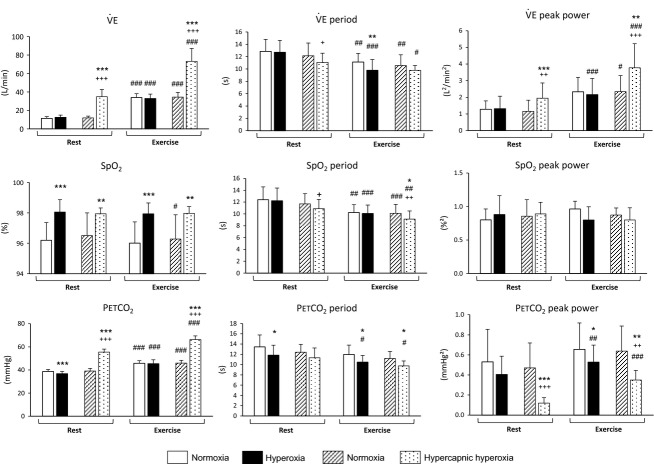
Mean (±SD) values of , SpO2, and PETCO2 and corresponding periods and peak powers in normoxia, hyperoxia, and hypercapnic hyperoxia. Exercise versus Rest: #P < 0.05; ##P < 0.01; ###P < 0.001. Hypercapnic hyperoxia or hyperoxia versus normoxia: *P < 0.05; **P < 0.01; ***P < 0.001. Hypercapnic hyperoxia versus hyperoxia: +P < 0.05, ++P < 0.01, +++P < 0.001.